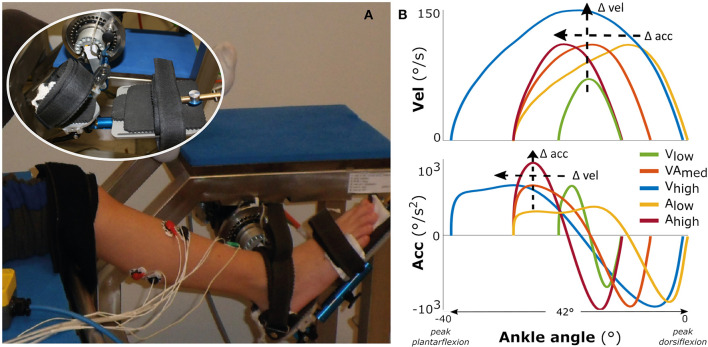
Measurement set-up and movement profiles. On the left (A) the motorized footplate with adjustable chair, with the foot fixation enlarged as inset. On the right (B) the imposed movement velocity (upper figure) and the imposed movement acceleration (lower figure) vs. the ankle range of motion, averaged over all participants.